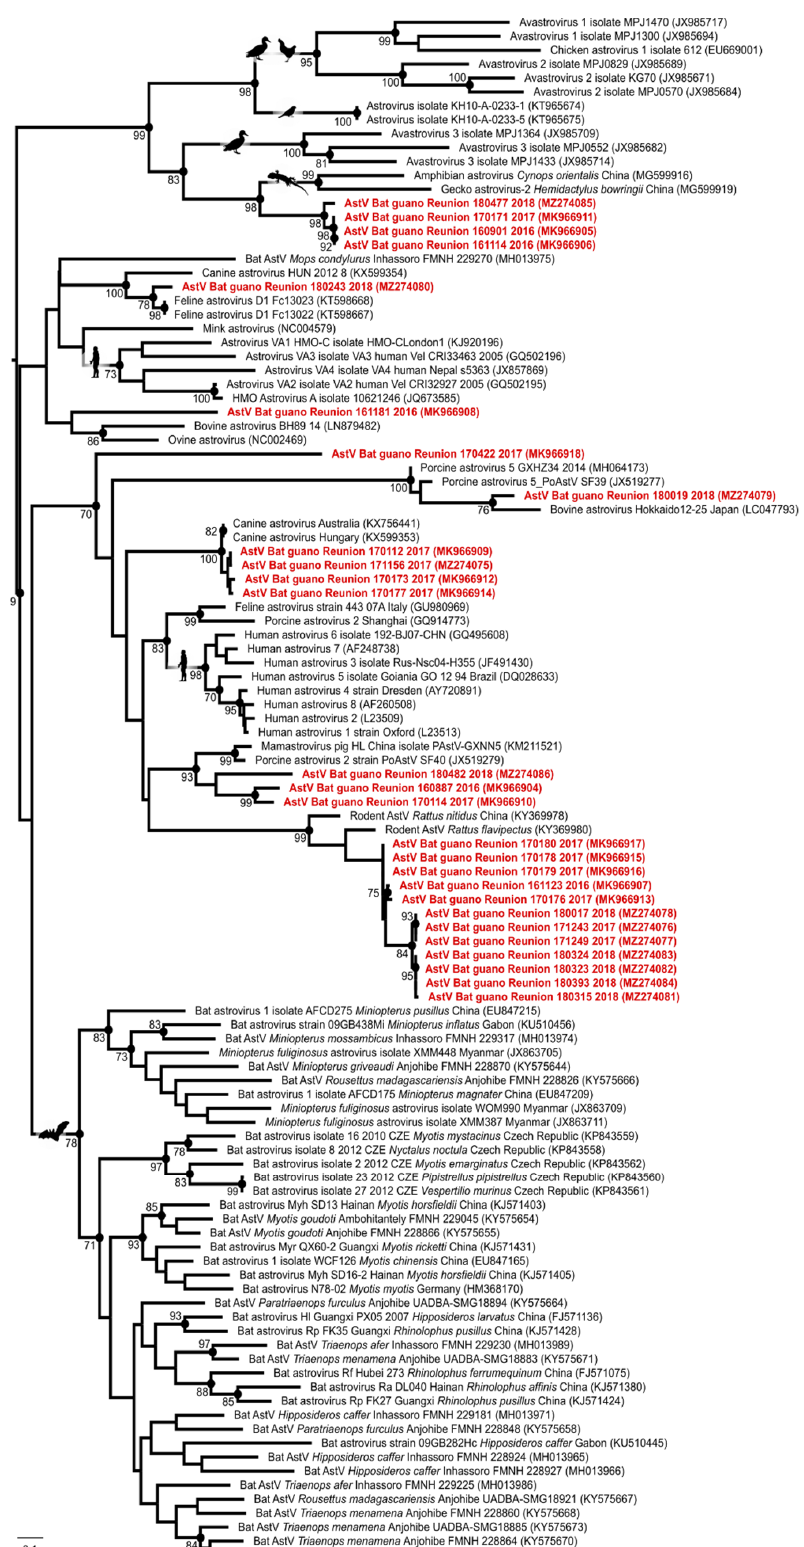
Figure 2. Maximum likelihood consensus tree derived from 111 Astrovirus (AstV) RNA-dependent RNA-polymerase partial nucleotide sequences (390 bp). Black dots indicate nodes with bootstrap values higher or equal than 70. Red: sequences generated in this study. Scale bar: mean number of nucleotide substitutions per site.